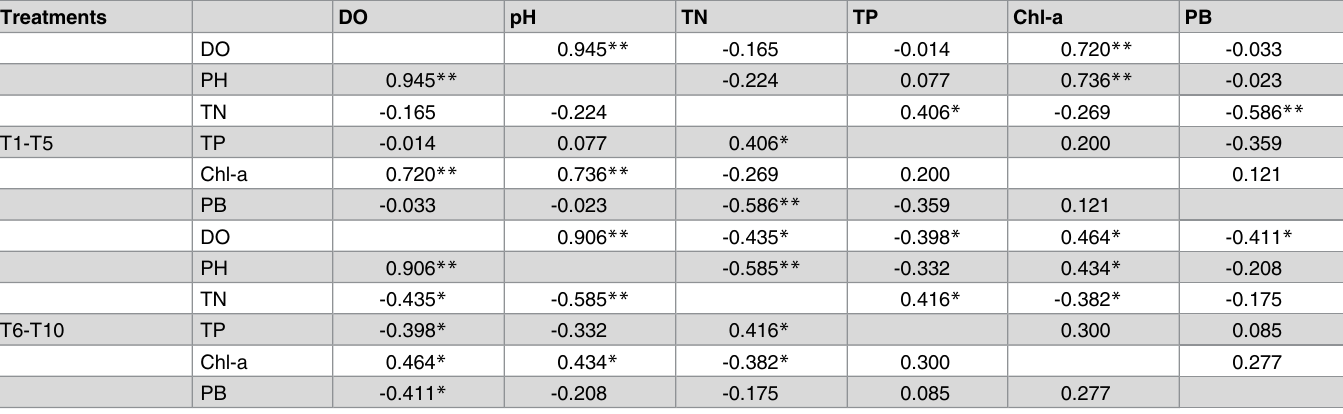
Table 5. The correlations among the water quality and biotic parameters for the treatments T1-T5 and T6-T10.